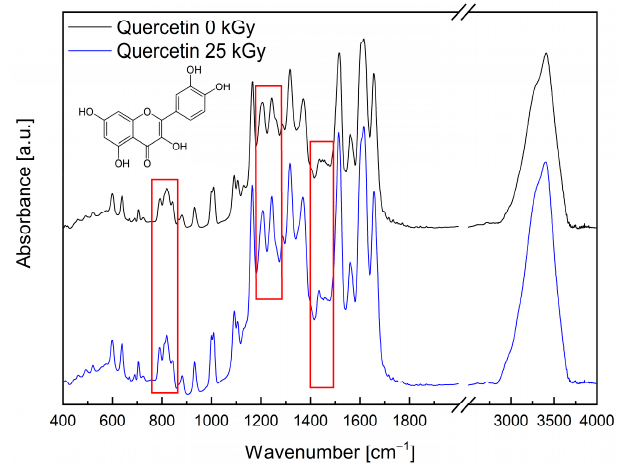
Figure 2. IR absorption spectra of non-irradiated (Quercetin 0 kGy—black) and irradiated (Quercetin 25 kGy—blue) quercetin at room temperature, range from 400 to 4000 cm − 1 .